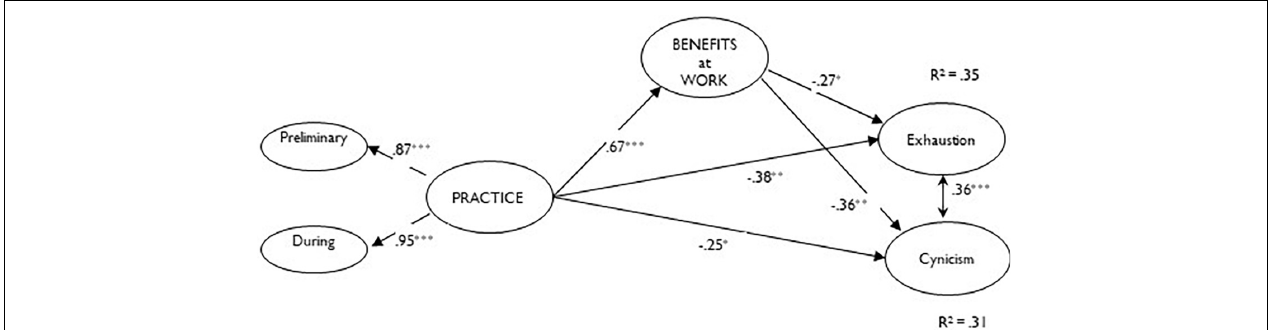
FIGURE 1 | Standardized coefficients for the final structural model. ∗∗∗ p < 0.001, ∗∗ p < 0.01, ∗ p < 0.05.